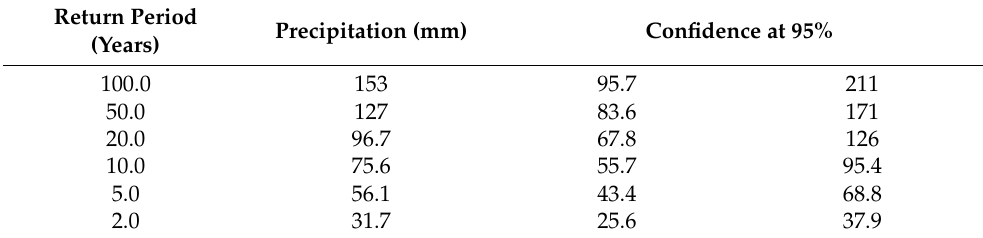
Table 2. The results at different return periods of extreme rainfall